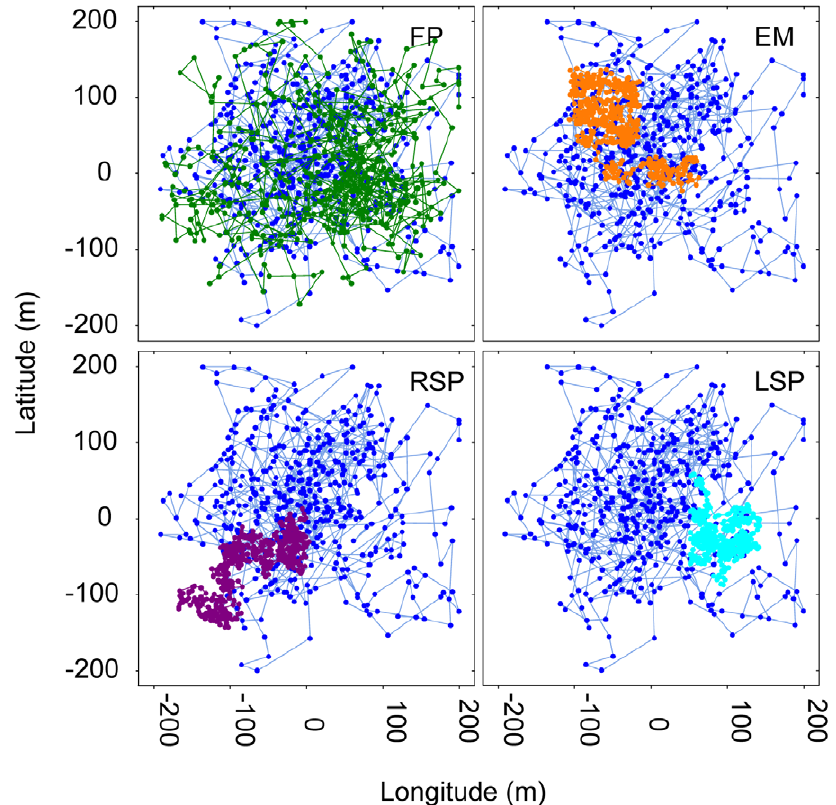
Figure 5. Lagrangian trajectories of the population-average fish in the original and exploited populations. The path of the first 500 time steps of an individual with average movement characteristics (ratio e /k and k ) sampled from the un-exploited population (in blue) and from the exploited population by the different fisher styles: the fisher fixed in one spot (FP), the fisher moving in the edge of the scenario (EM), the random search pattern (RSP) and Le´vy search pattern (LSP). Note the change in the tortuousity degree and a needing for more time steps to reach an asymptote (HR) in the spatial-utilisation in the exploited average fish.